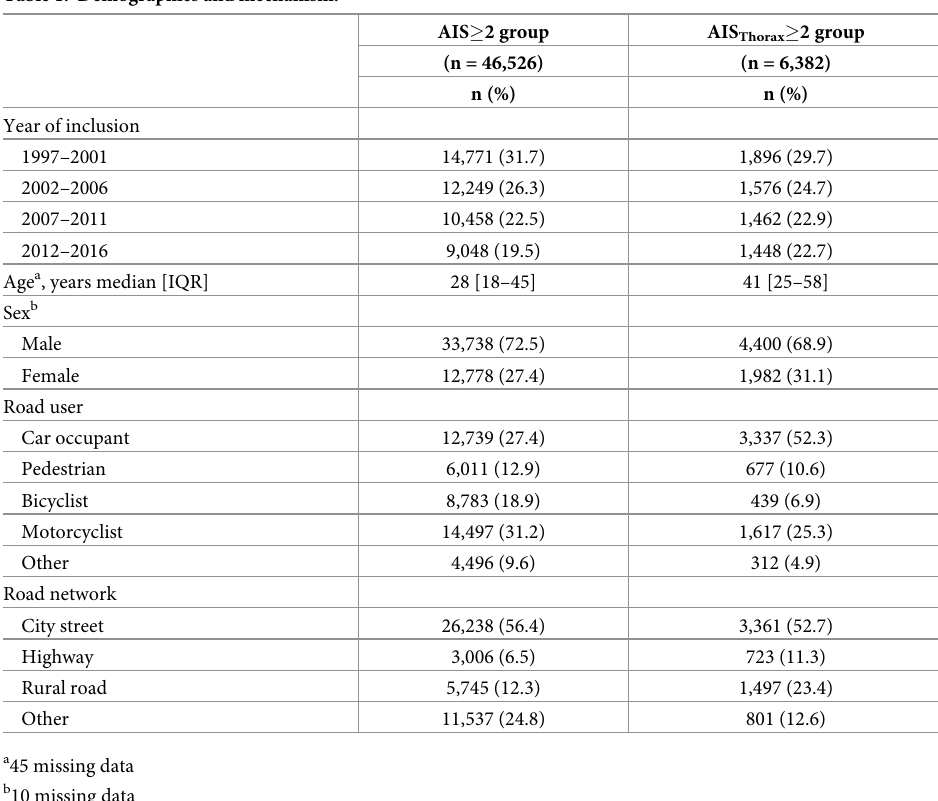
Table 1. Demographics and